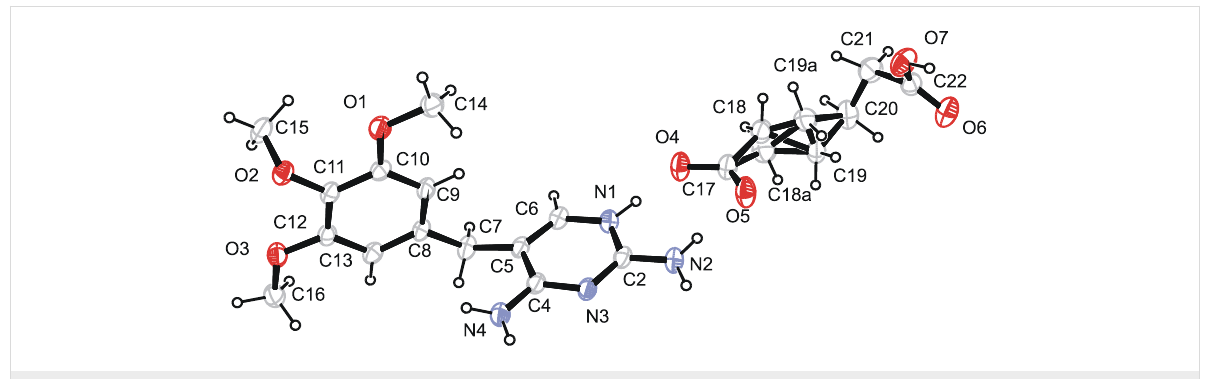
Figure 4: The ORTEP 3 view of the asymmetric unit of the compound 2 .